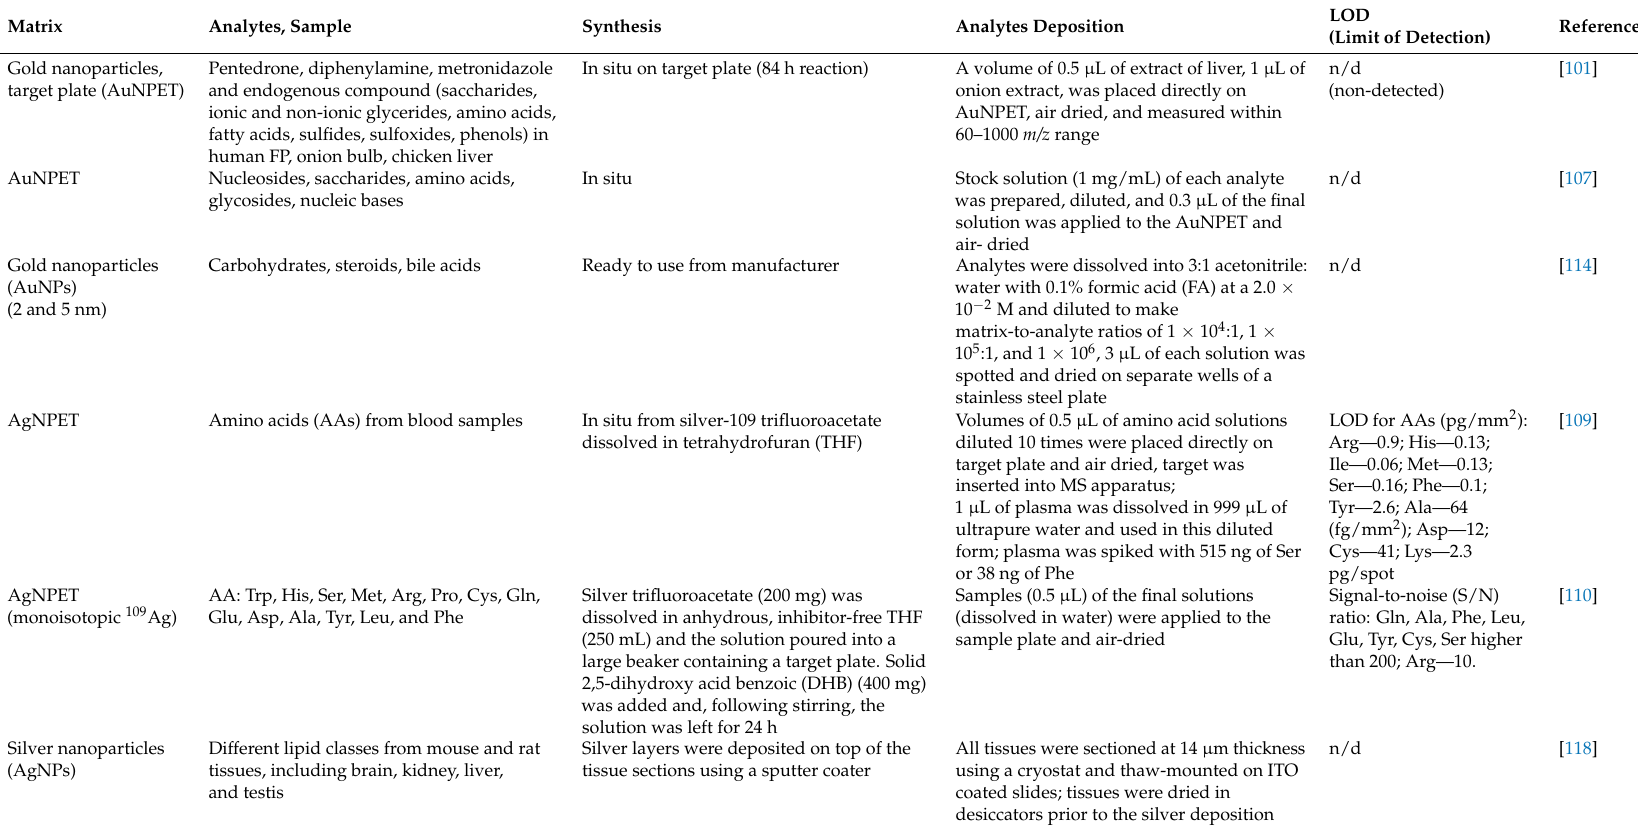
Table 2. Review of application of metal and metal oxide nanoparticles for laser desorption/ionization (LDI)